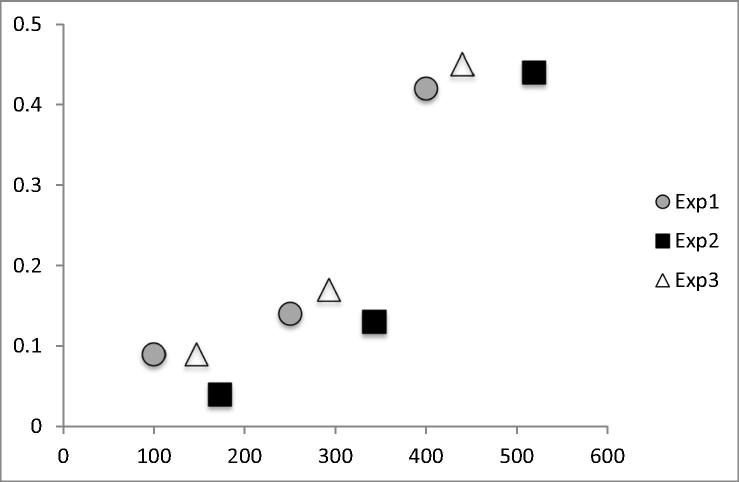
Inhibition functions depict the relation between p(respond|signal) (Y-axis) and stop-signal delay (X-axis).